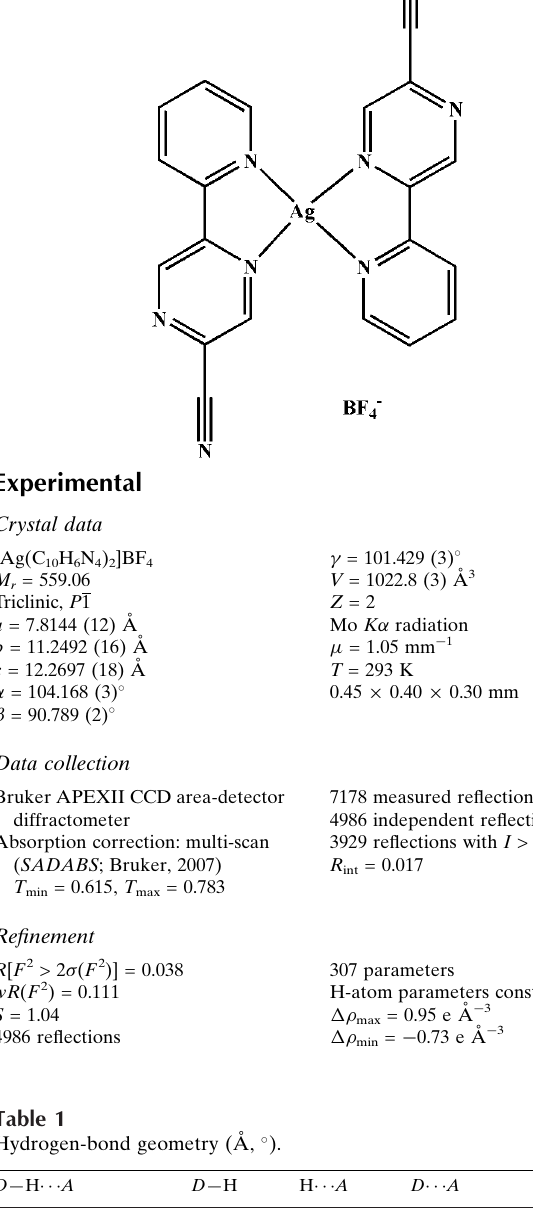
Hydrogen-bond geometry (A˚ , (cid:3)